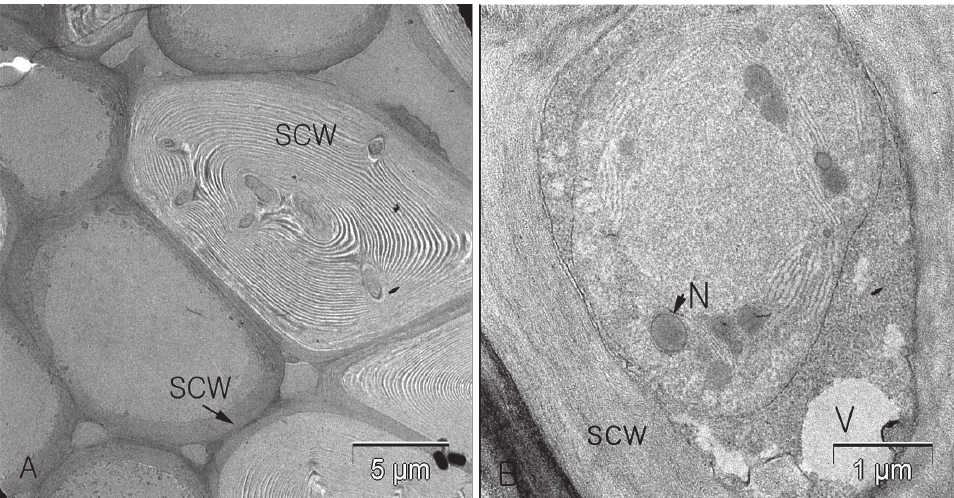
Fig. 6: Morphological characteristics of a stone cell observed in flesh of ‘Niitaka’ pear using TEM on 150 DAFB (A; B). N: nucleolus, SCW: secondary cell wall, and V: vacuole